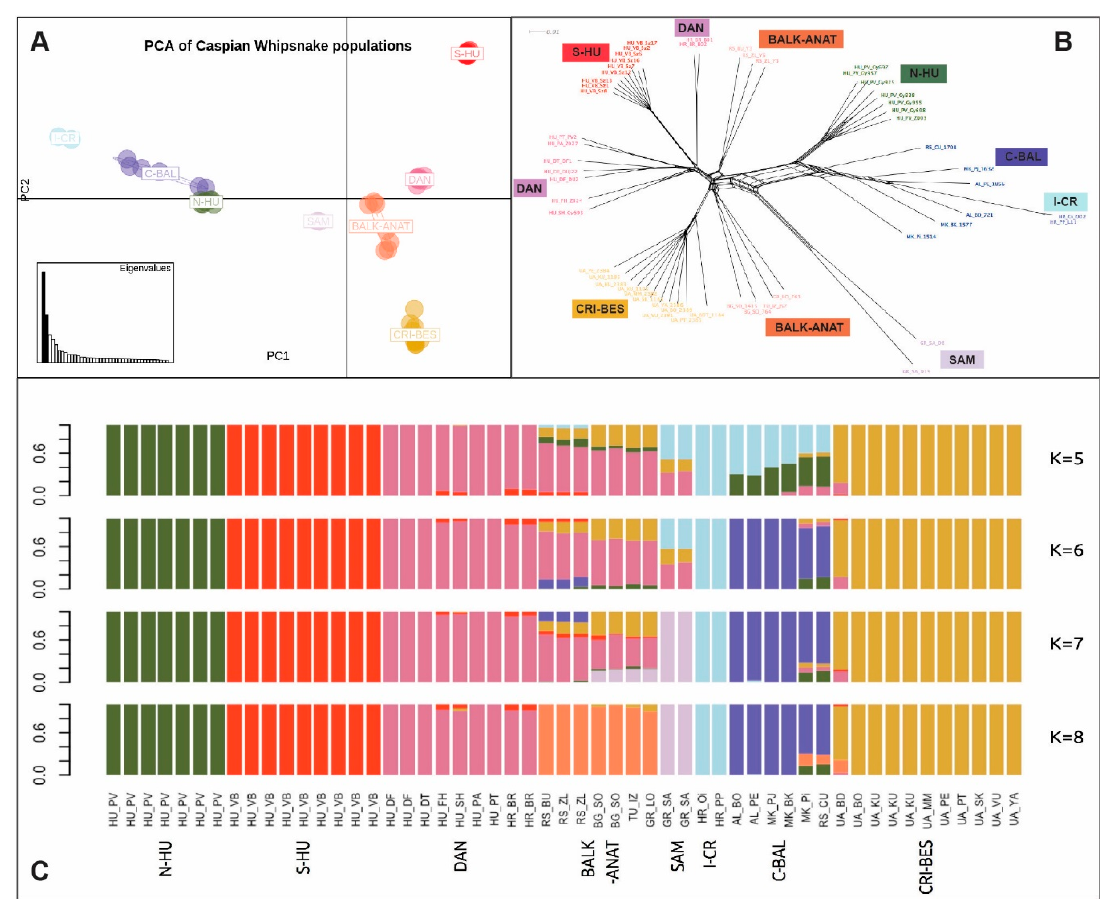
Figure 2. ( A ) Principal Component Analysis of 53 D. caspius individuals. The first and second principal components explain 22.3% and 11.9% of the genetic variation in the dataset, respectively. ( B ) Unrooted NeighbourNet network tree displaying relationships among the 53 D. caspius individuals based on genetic distance. ( C ) Admixture barplots for K = 5–8 in 53 individuals. Populations are labeled, corresponding to Table 1.